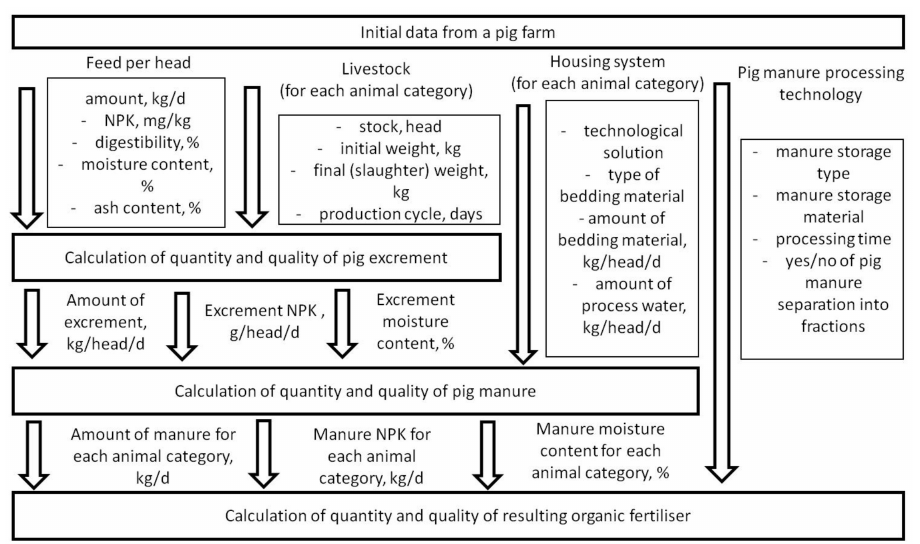
Figure 3. Sequence of calculating the quantity and quality of the pig manure as an initial material for obtaining the end-products—organic